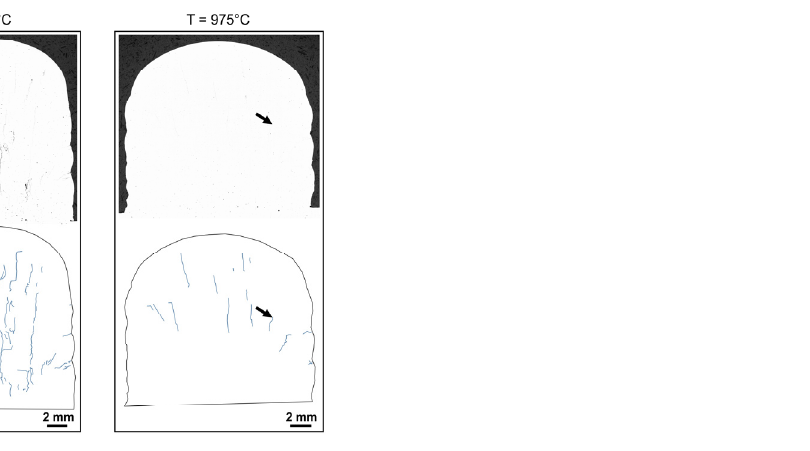
Figure 6. Polished cross-sections ( top ) and crack visualization ( bottom ) for cubes with 15 mm edge length fabricated without ( left ) and with ( right ) laser preheating to increase the initial substrate temperature T. The arrows show the location of an exemplary crack that is illustrated at higher magnification in the following figure.